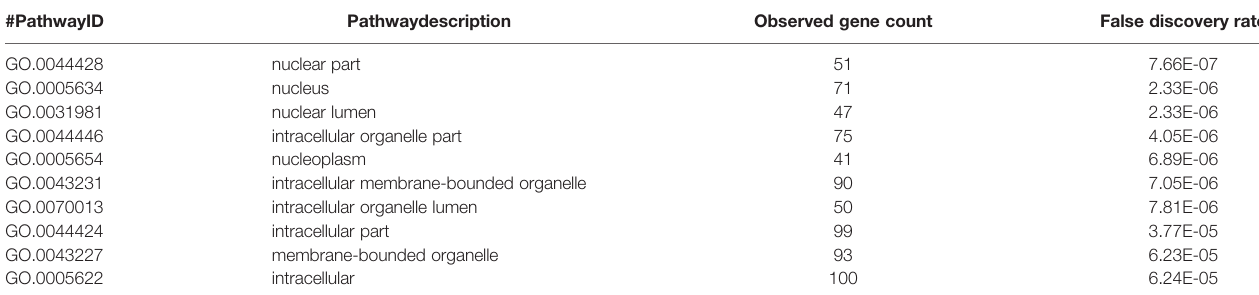
TABLE 1 | Component annotation of 138 differentially expressed genes.